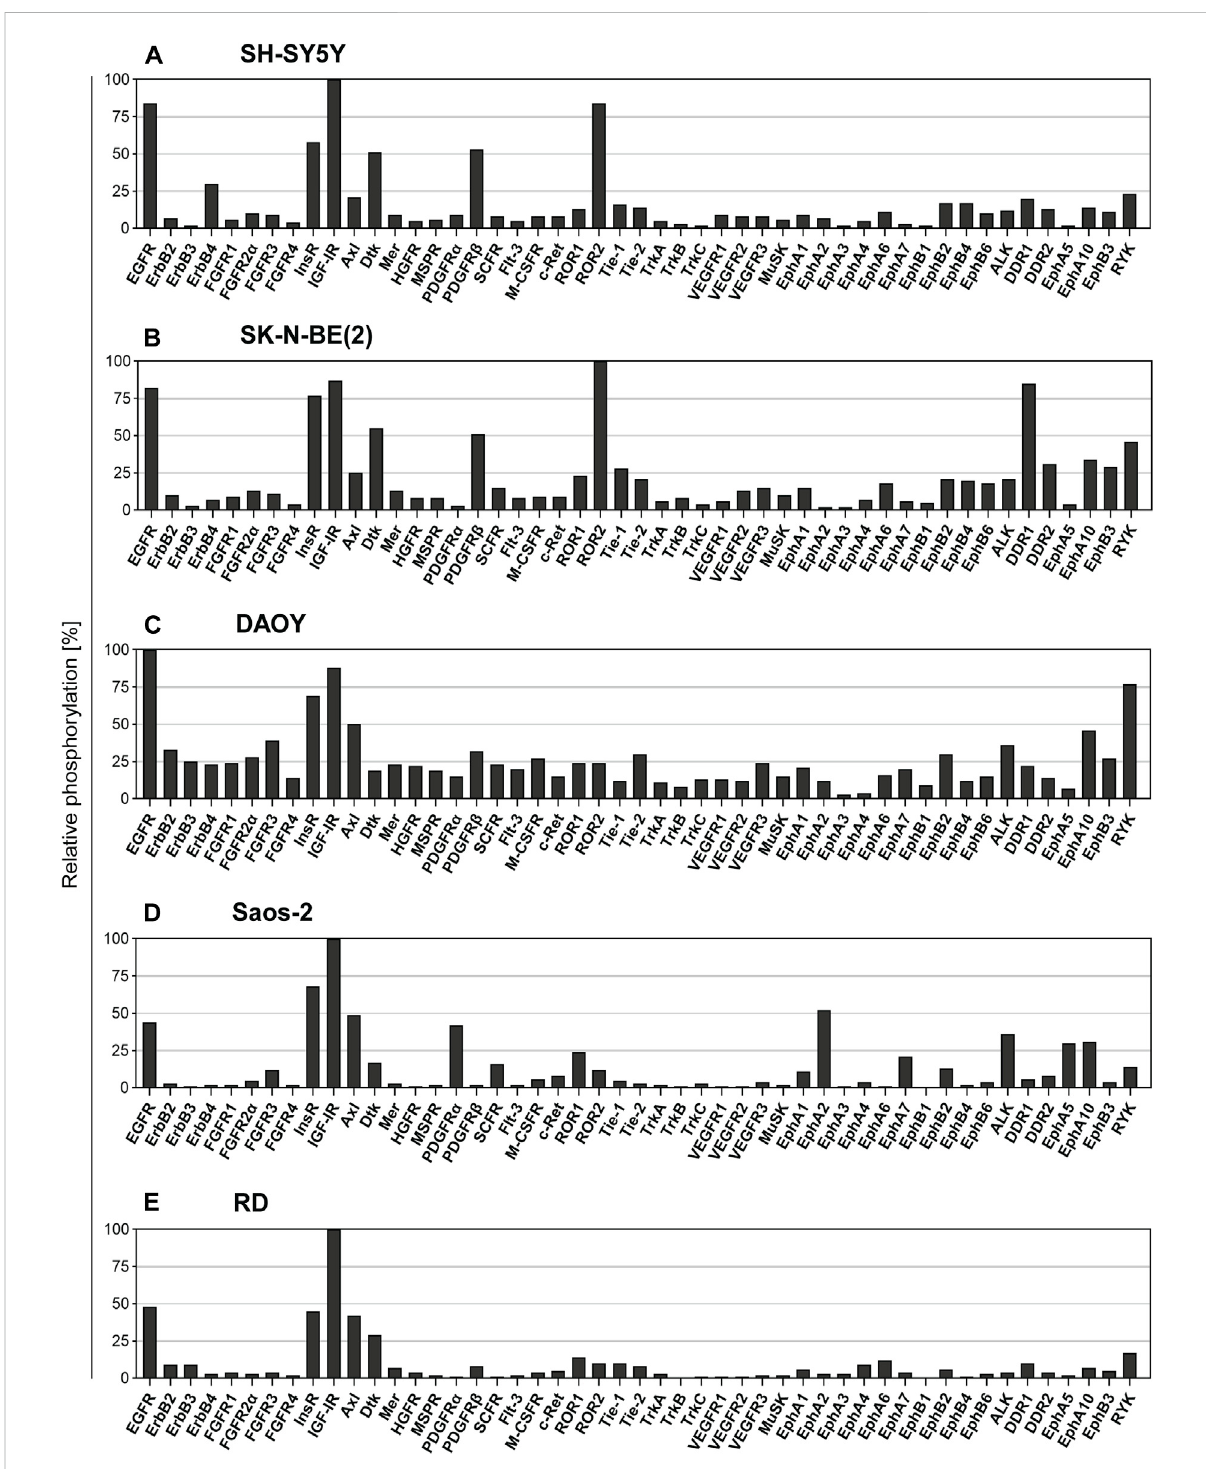
FIGURE 2 ScreeningofthelevelsoftheRTKphosphorylationinuntreatedcelllines.Therelativephosphorylationlevelsof49RTKswereassayedinthecell lines: (A) SH-SY5Y and (B) SK-N-BE (2) cells derived from neuroblastoma, (C) DAOY cells derived from medulloblastoma, (D) Saos-2 cells derived fromosteosarcoma,and (E) RDcellsderivedfromrhabdomyosarcoma.ColumnsrepresentthelevelsofrelativephosphorylationofRTKsassessedas described in Materials and Methods. The corresponding array images are shown in Supplementary Figure